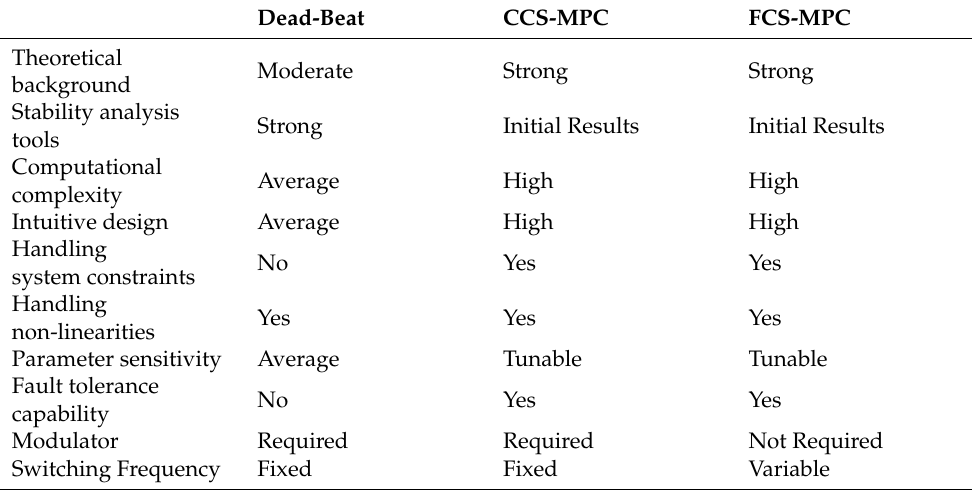
Table 1. Overview of control